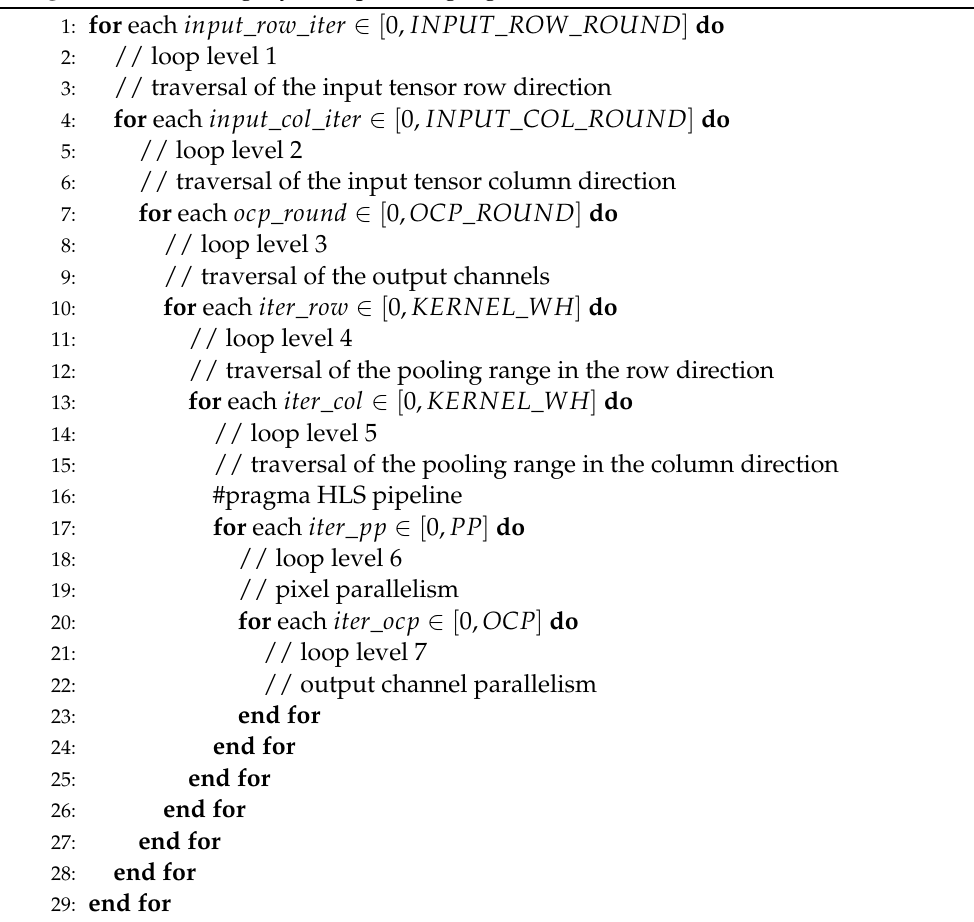
Algorithm 2: Pooling layer loop nesting algorithm